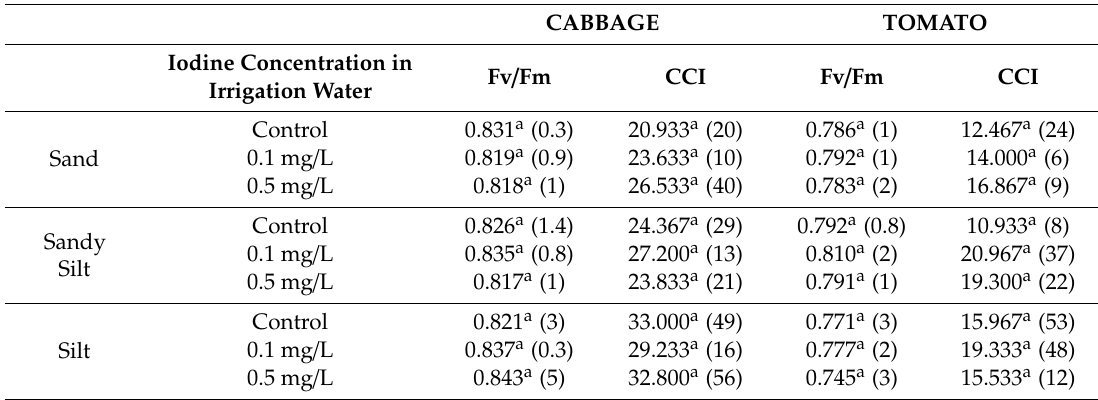
Table 2. E ff ect of iodine concentrations in irrigation water on the photosynthetic e ffi ciency (Fv / Fm) of photosystem (PS) II and chlorophyll content index of leaves (CCI). The values indicate the means of three replicates (RSD%), while di ff erent letters indicate statistically significant di ff erences between treatments ( p < 0.05; linear regression and Tukey’s